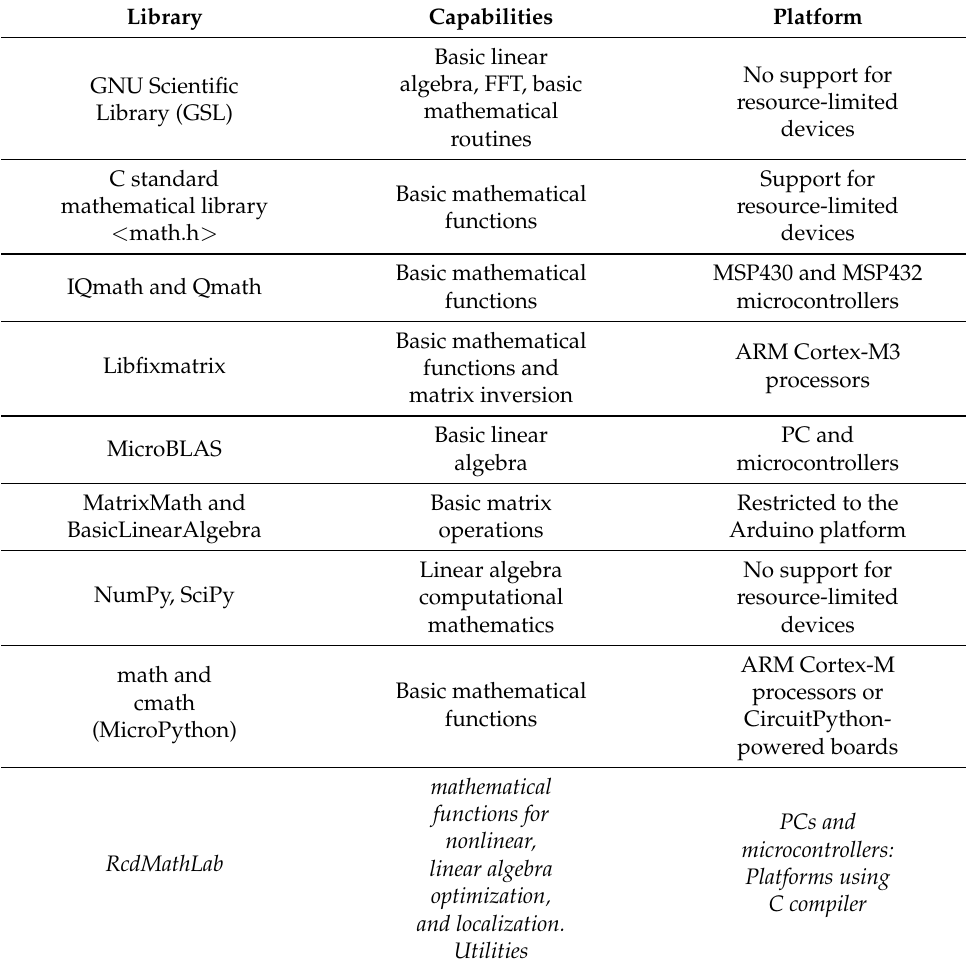
Table 1. Comparison of mathematical libraries. FFT, Fast Fourier